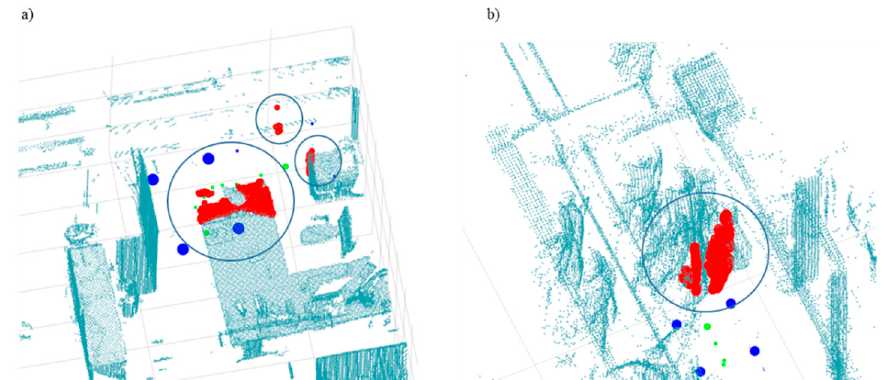
Figure 18. Zoomed view of the office room during the “Node C to office door” test for the wheelchair buffer ( a ) and during the “Node H to Node I” for walking people ( b ). In both cases, the destination could not be reached due to the presence of static and dynamic obstacles, respectively.